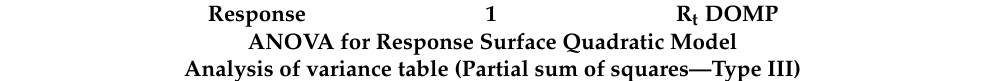
Table 6. ANOVA for response surface for R t DOMP.